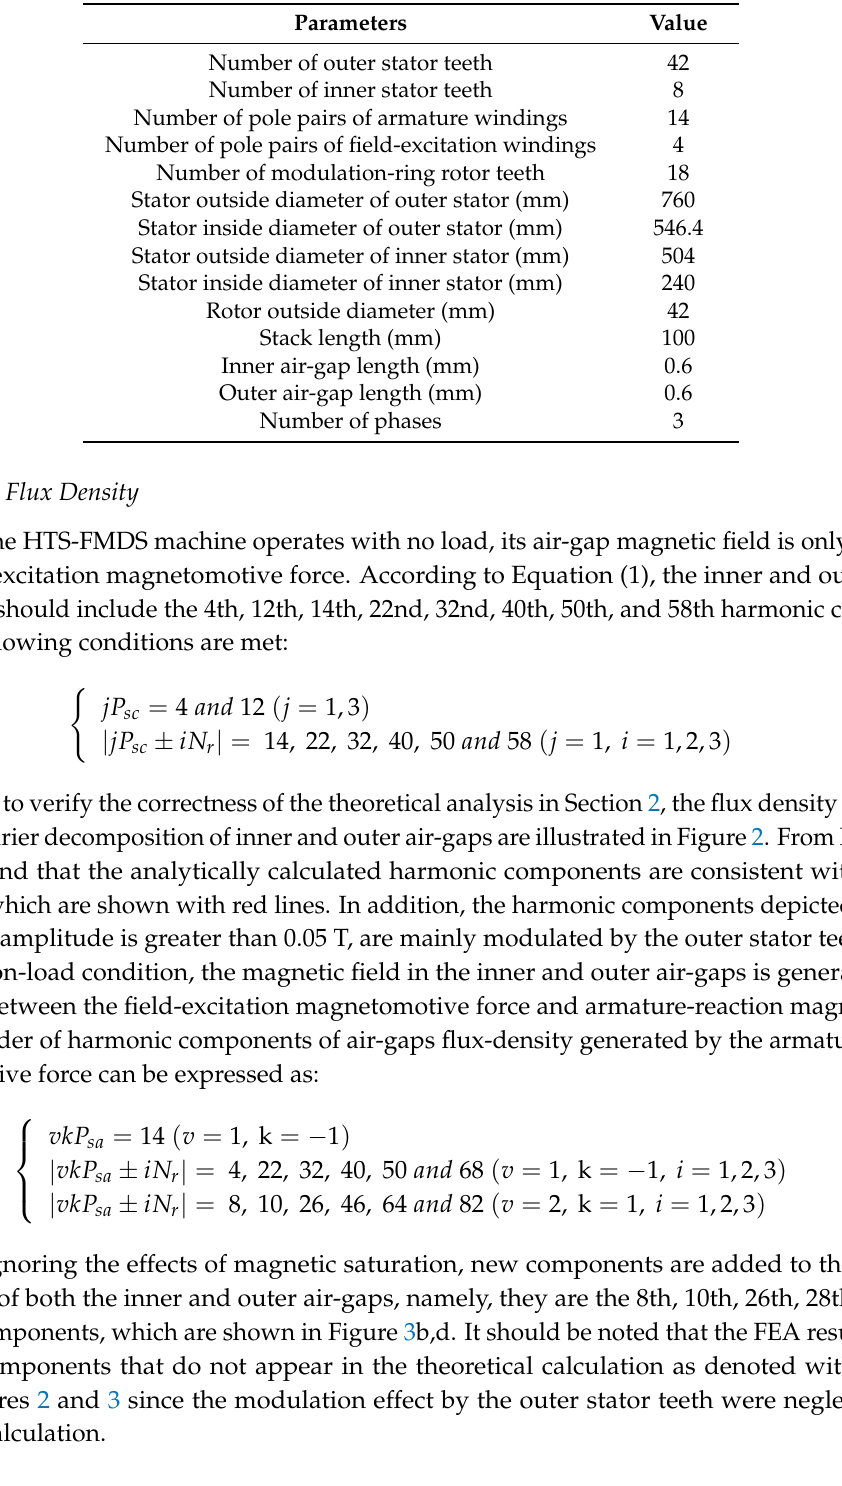
Table 2. Key size parameters of the HTS-FMDS